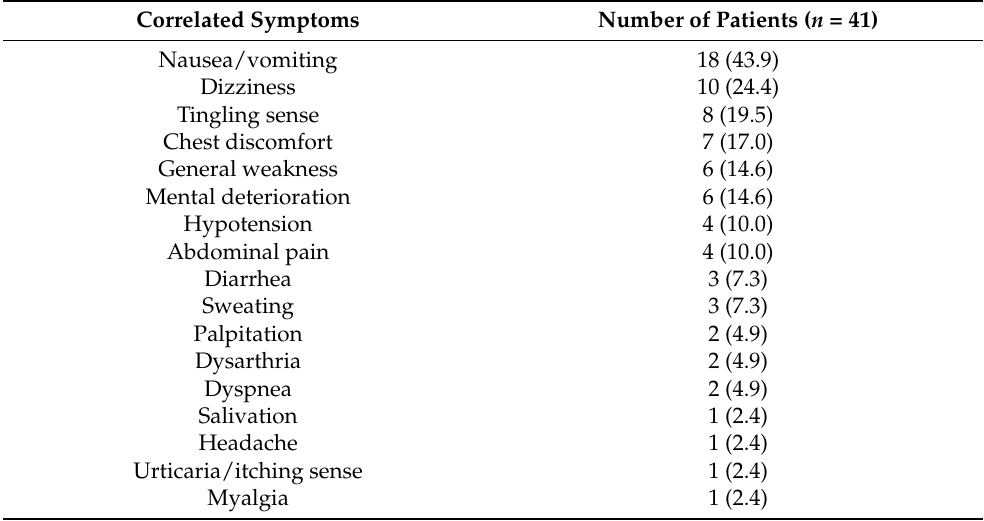
Table 1. Baseline characteristics of clinical symptoms.